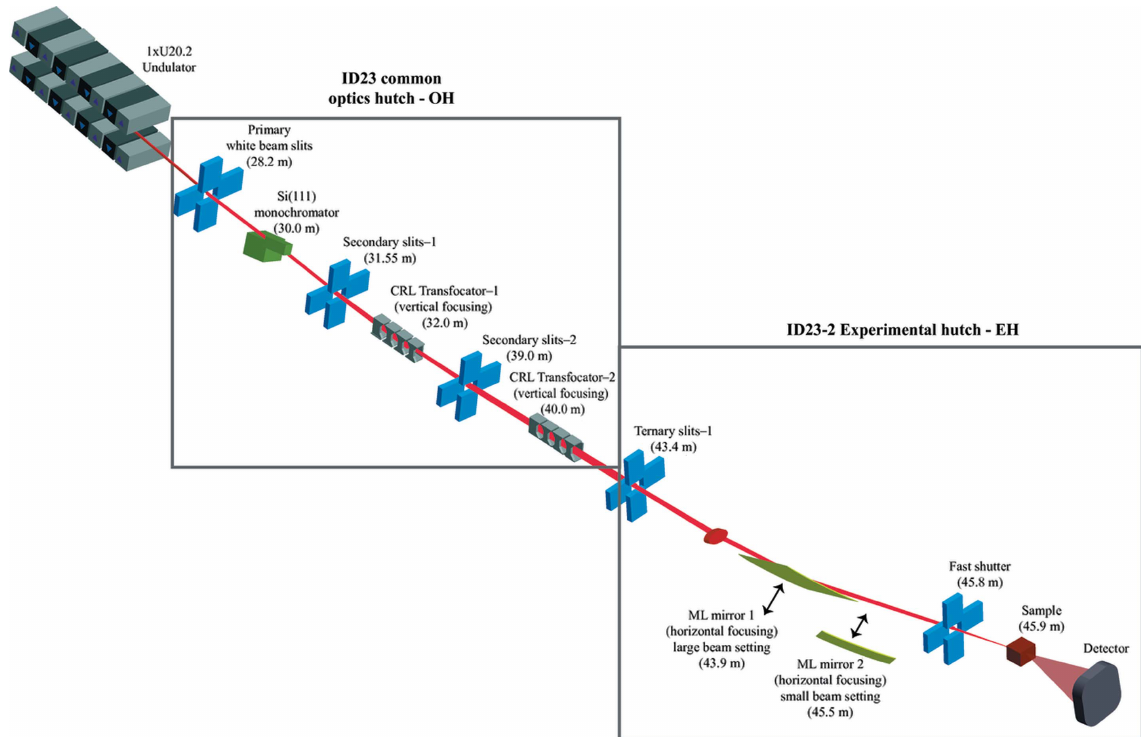
Figure 1 Optical layout of ID23-2. Distances from the source are shown in parentheses. ID23-2 shares a common optical hutch with ID23-1. In the optics hutch (rectangle on the left), energy selection and beam deflection are achieved by the monochromator (green) and vertical focusing is performed by sets of CRLs in transfocators. In the experimental hutch (shown in the rectangle on the right), the beam is then horizontally focused by one of the two multilayer